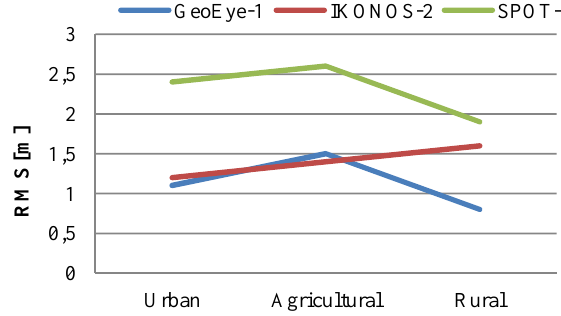
Figure 7. Root mean square coordinate differences at independent check points - tie points determined by matching - scene orientation by bias corrected RPC